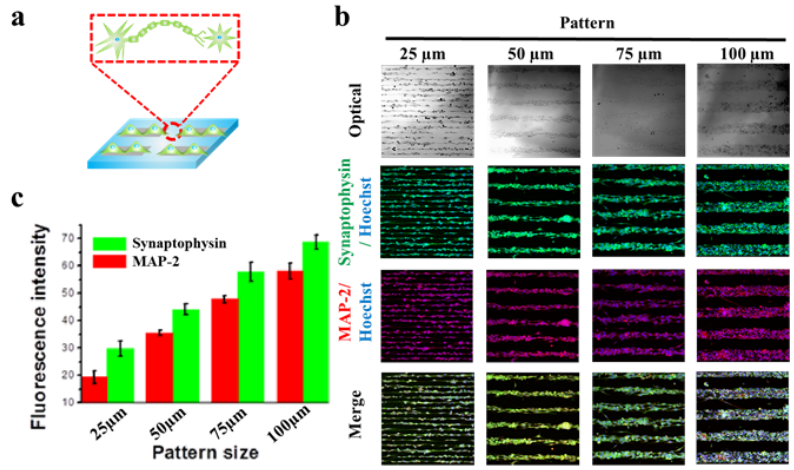
Figure 4. Synaptogenesis in different sized GO hybrid line patterns. ( a ) Schematic diagram of synaptogenesis of aligned cells on GO hybrid line pattern. ( b ) Phase contrast (top row) image and confocal images of aligned cells on different sized GO hybrid patterns (25, 50, 75, 100 μ m) stained for synapse (green) and nucleus (blue) (second row), cytoskeleton (red) and nucleus (blue) (third row) and merged (last row) after 2 days of culture. ( c ) Quantitative comparison of synaptophysin and MAP ‐ 2 fluorescence intensity in 100 μ m × 100 μ m area of different sized patterns. Data are the mean ± standard deviation of three different experiments.